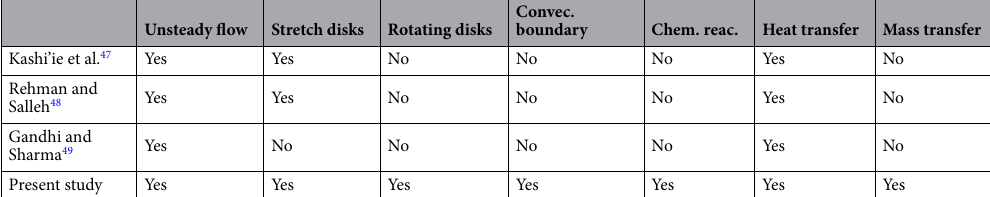
Unsteady flow Stretch disks Rotating disks